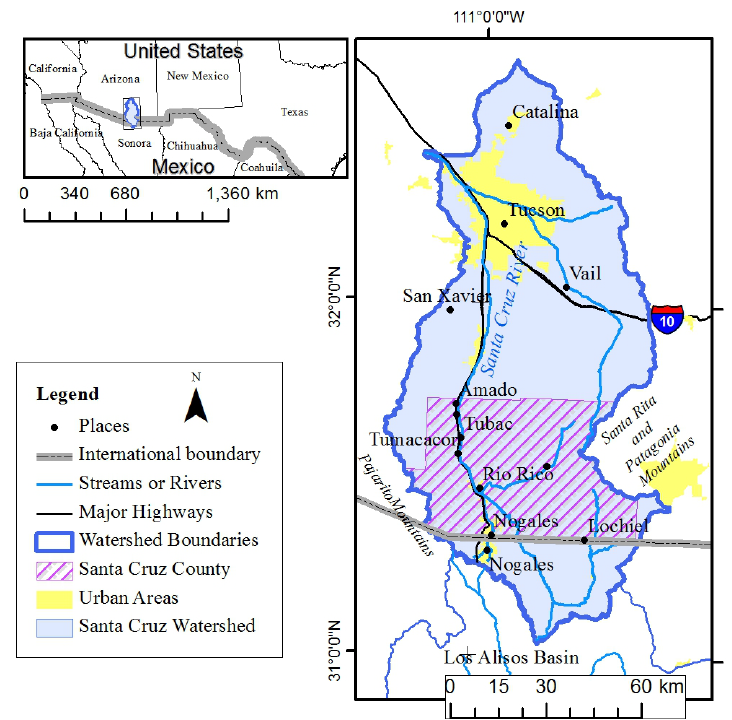
Figure 1. Location map of the Santa Cruz Watershed, Santa Cruz County, towns, streams and boundaries.